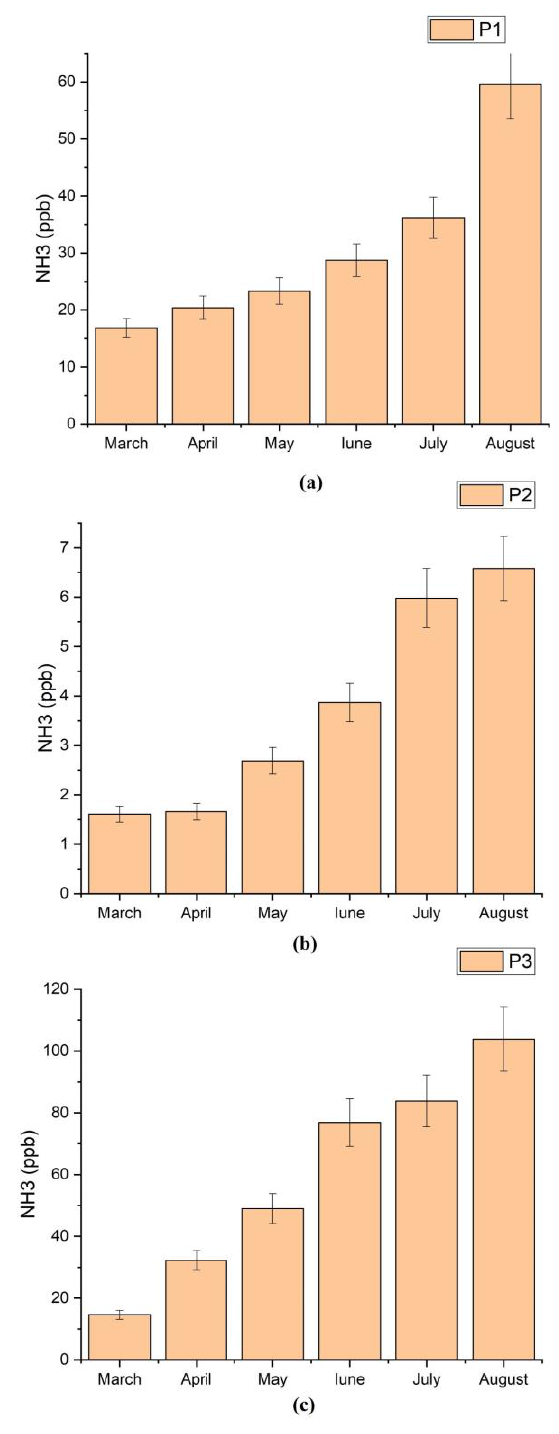
Figure 5. Monthly average ammonia concentration during the period March–August 2021: ( a ) P1 monitoring point, ( b ) P2 monitoring point, ( c ) P3 monitoring point.